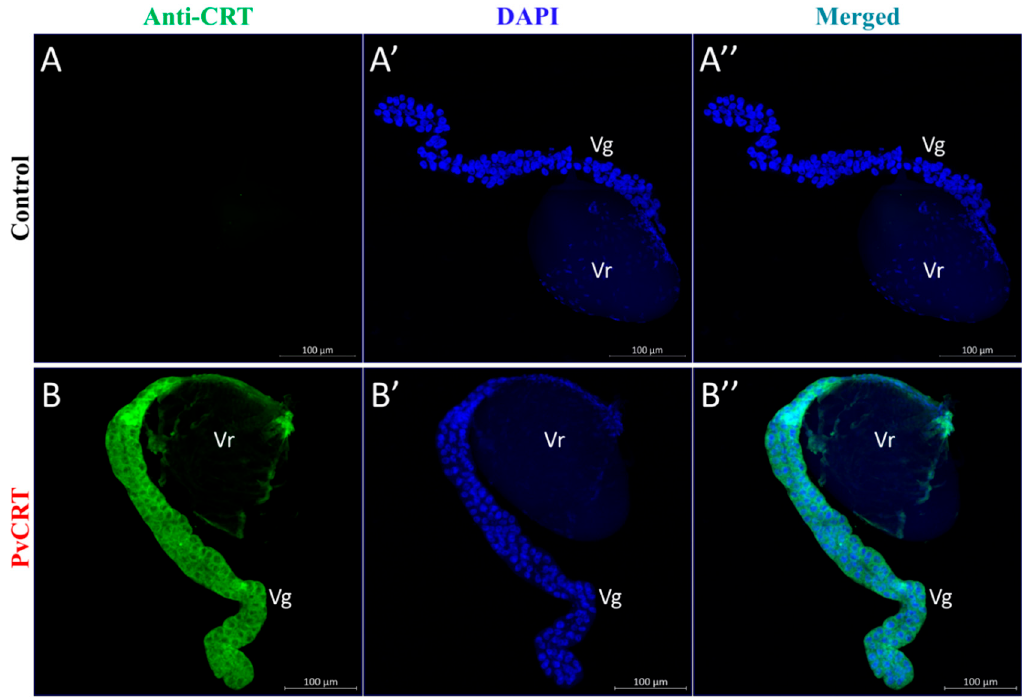
Figure 5. Immunolocalization of PvCRT antigen in venom apparatus, including venom gland (Vg) and venom reservoir (Vr). ( A – A’’ ). PvCRT was detected using rabbit anti-PvCRT polyclonal antibody and Dylight 488-conjugated goat anti-rabbit secondary antibody. ( B – B’’ ). Rabbit serum that had not been immunized was used as control. Cell nuclei were stained with DAPI ( A’ , B’ ).